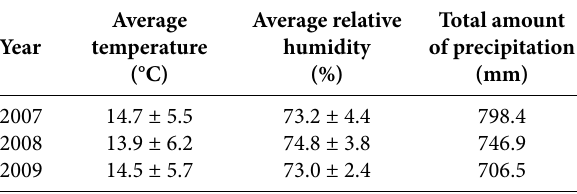
Table 4. Weather conditions from March to August reported by the Slovenian Environmental Agency.